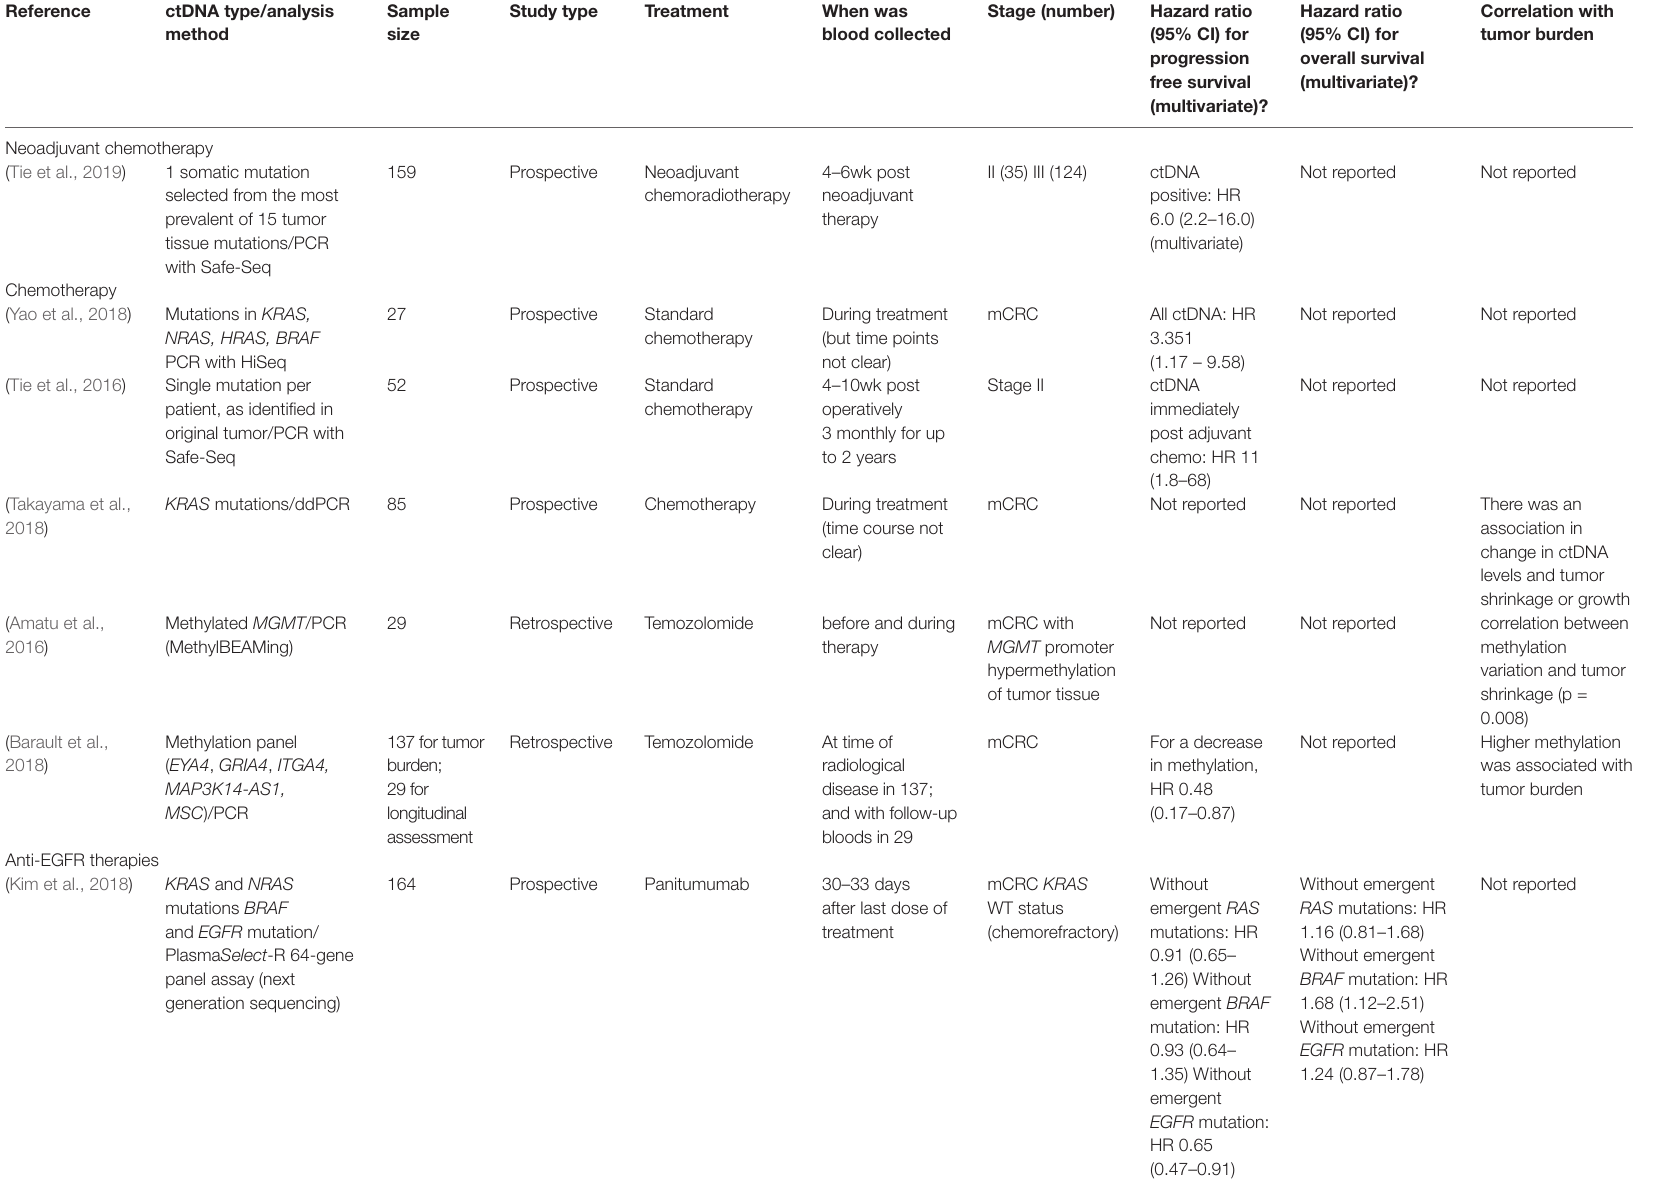
TABLe 2 | Monitoring response to therapy with circulating tumor DNA